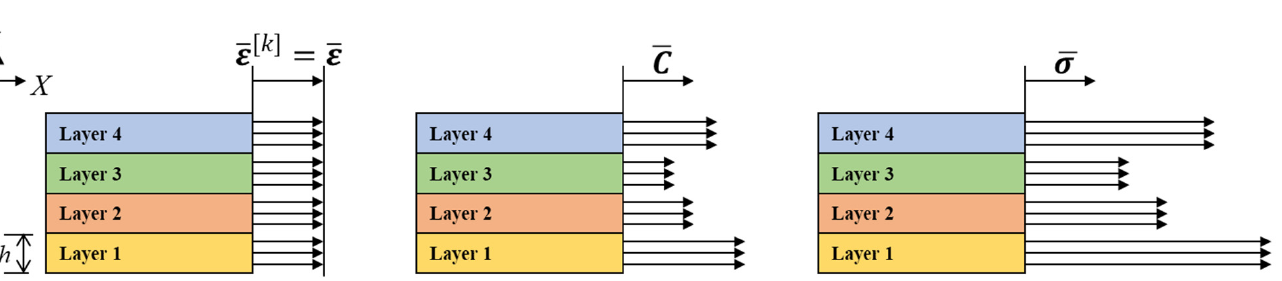
Figure 1. Schematic representation of Equation (1).